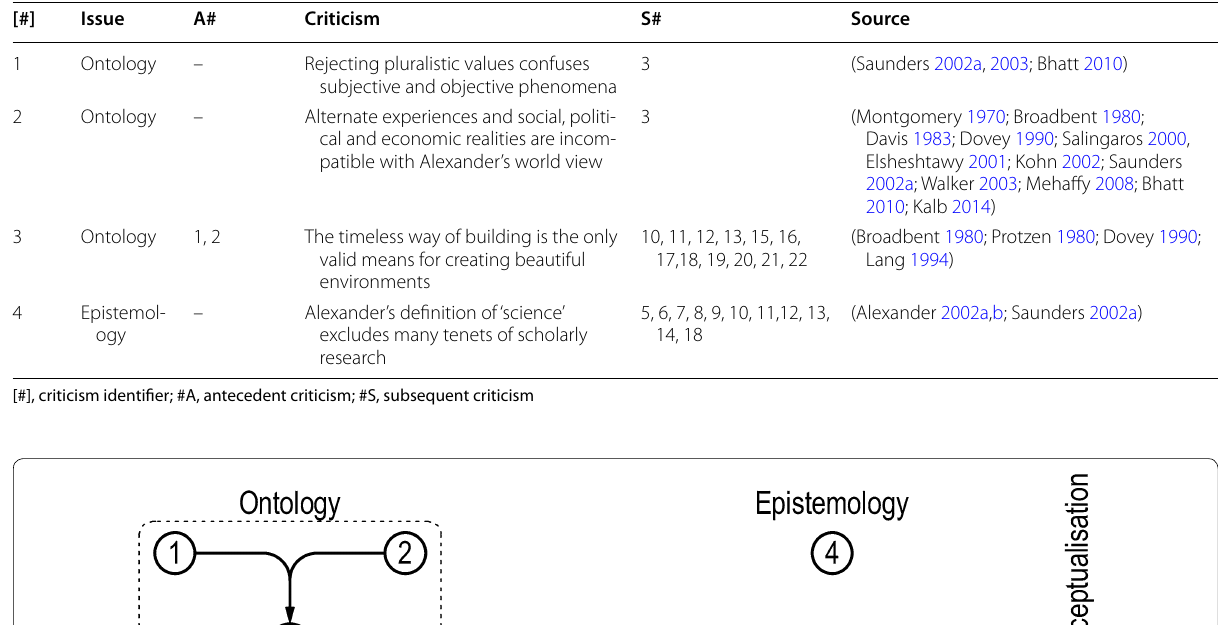
Table 1 Criticisms of Alexander’s second theory of architecture: conceptualisation